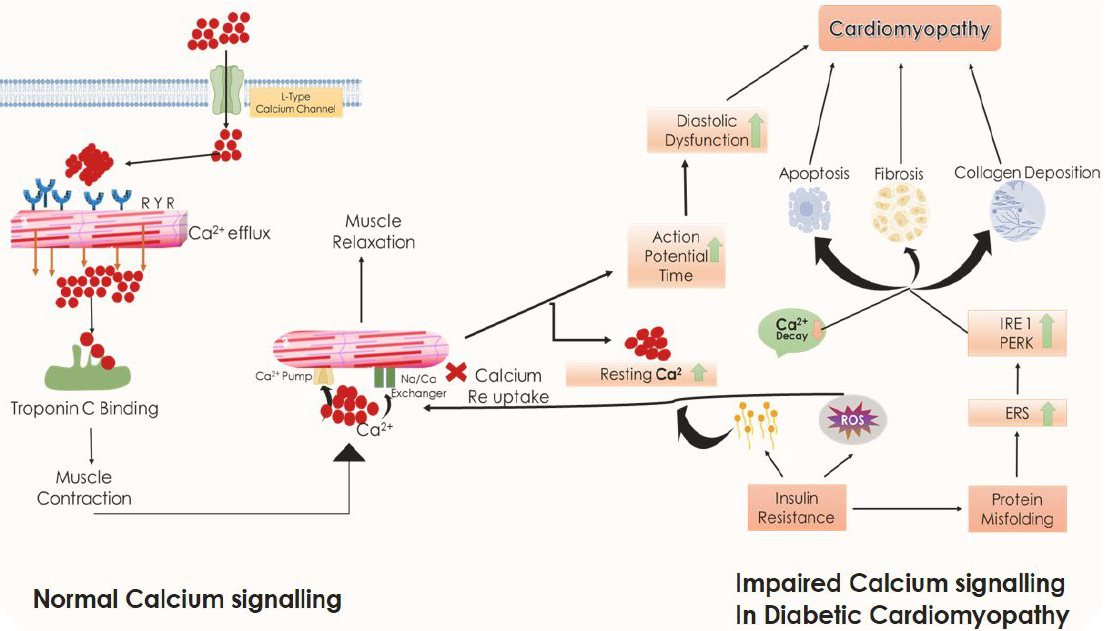
Figure 5. Comparison of normal calcium signaling with diabetic cardiomyopathy calcium signaling. Black arrows represent downstream events. ERS, endoplasmic reticulum stress; IRE1, inositol-requiring kinase-1; PERK, protein kinase R-like endoplasmic reticulum kinase; ROS, reactive oxygen species.